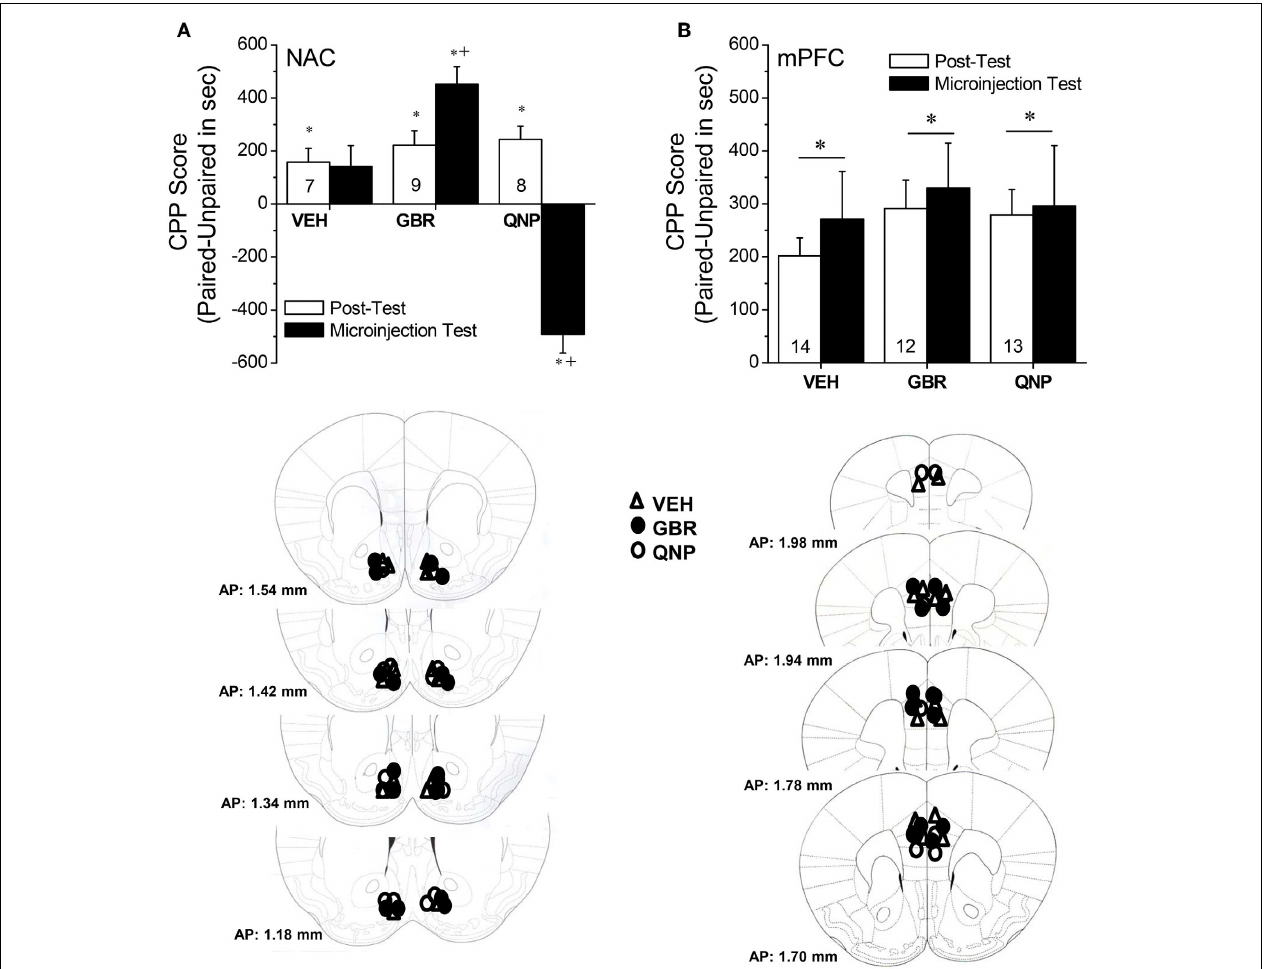
FIGURE 5 | Summaryofchangesinthedifferenceinthetimespent(insec) in an environment previously paired with 2mg/kg methamphetamine (Paired) vs. an environment paired previously with saline (Unpaired) (i.e., CPP Score) produced by intra-NAC (A) or intra-mPFC (B) infusions of